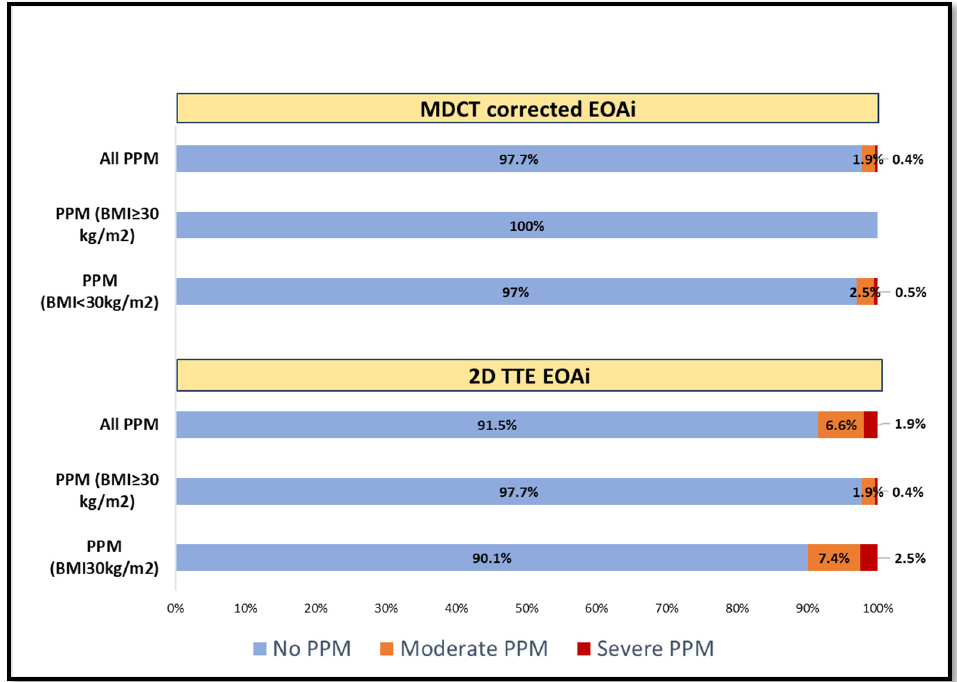
Figure 2. Incidence of PPM (BMI adjusted) based on the EOAi assessed by 2D-TTE and MDCT- corrected method; (All PPM; moderate or severe (2.3% (MDCT-corrected) vs. 8.5% (2D-TTE).